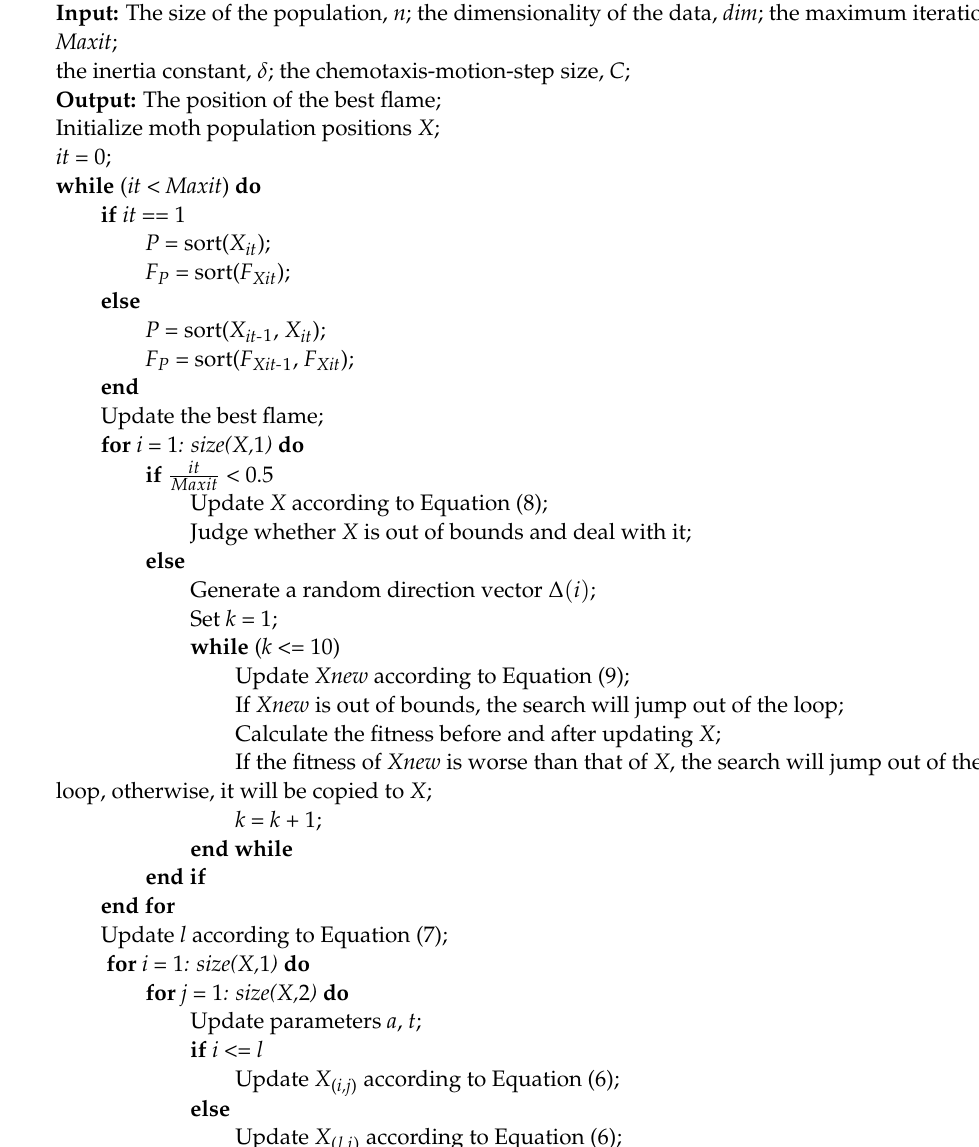
Algorithm 2 Pseudocode of